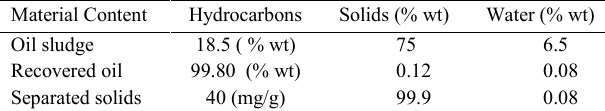
Table 4: Recovered hydrocarbon properties from the sludge sample